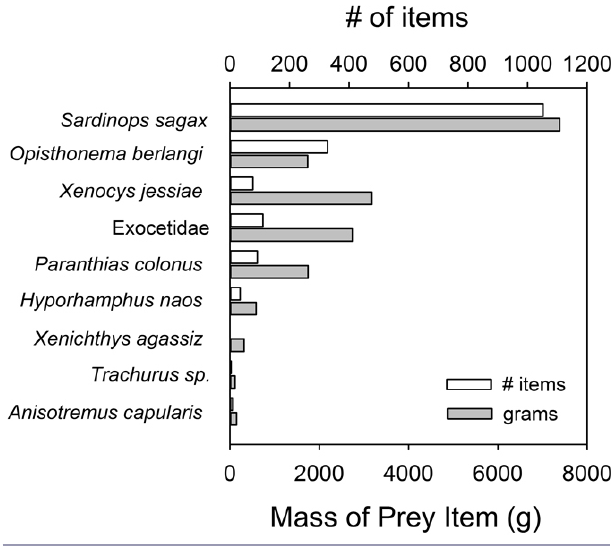
Fig. 3 . Proportion of each fish taxon in regurgitation samples, by number of items, n = 1721 and weight, total = 18,117 g. The two species at the top are Clupeid. Not shown: Panamic sergeant major ( Abudefduf troschelii ), three items, 99 g; Carangids ( Caranx spp.), three items, 20 g; Cortez rainbow ( Thalassoma ucasanum ), five items, 38 g; squid Decapodiformes, one item, < 1